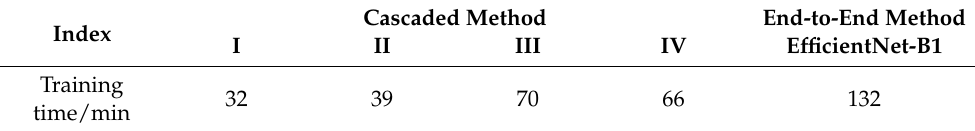
Table 5. Training times of different individual identification methods.